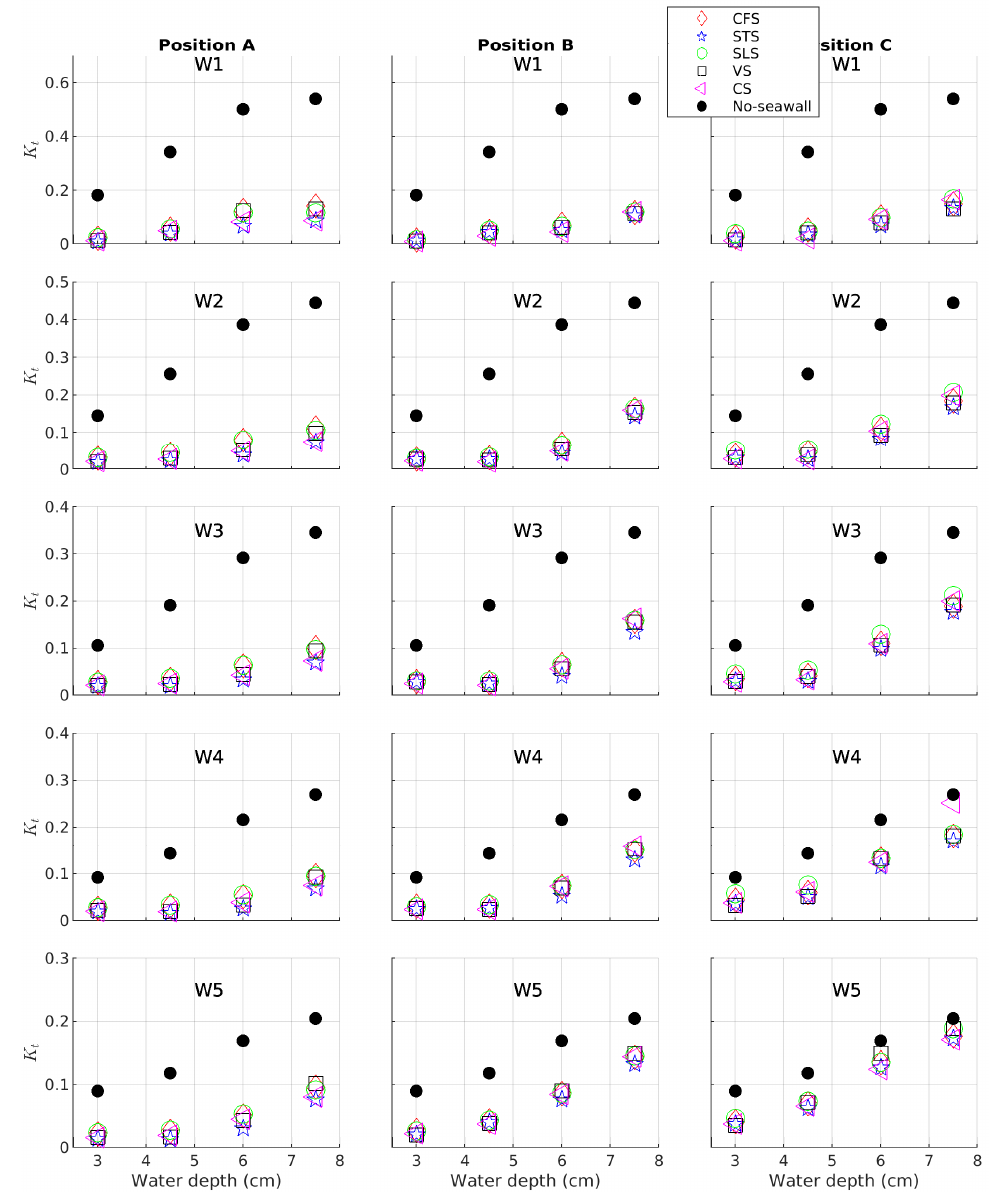
Figure 4. SW transmission coefficient vs. reef flat water depth. Water depth, wave condition, seawall position, and seawall shape are depicted with the x -axis, rows, columns, and colored markers, respectively. Note the difference in y -axis